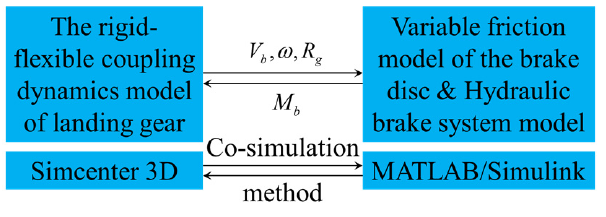
Figure 7. Co-simulation method. The parameters required in the simulation process are shown in the Table